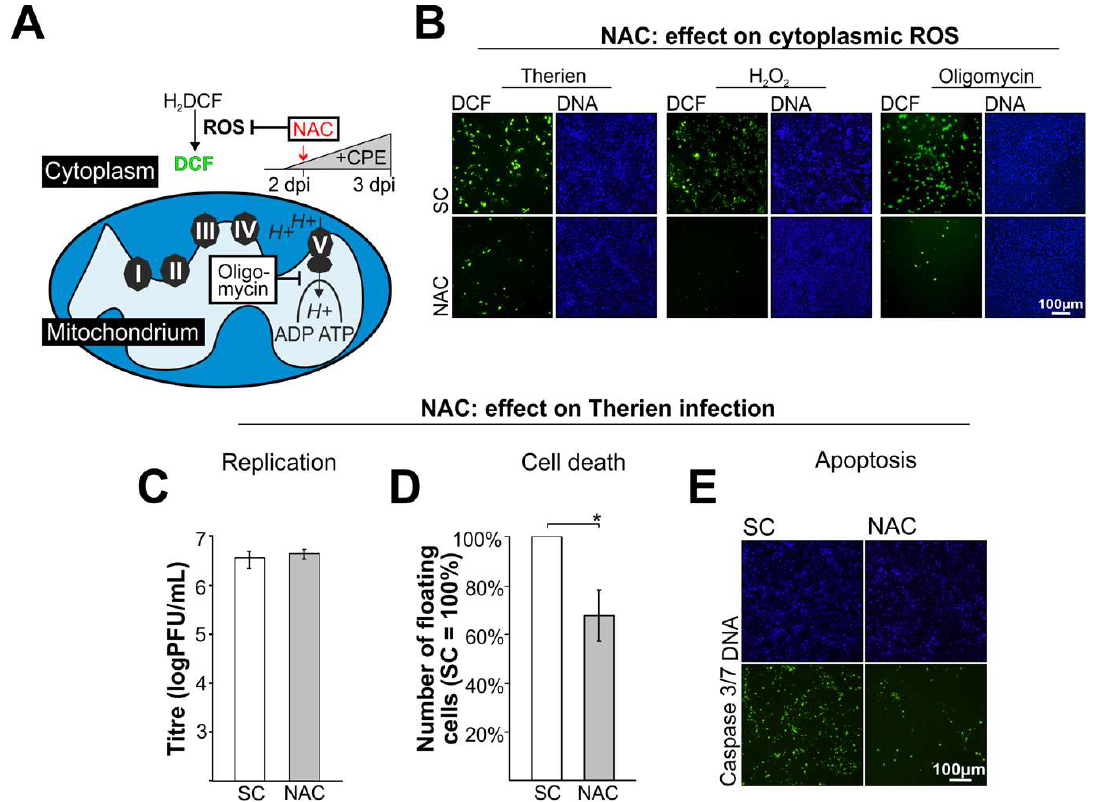
Figure 2. The ROS scavenger N -acetyl- L -cysteine (NAC) reduces RV-associated cytopathogenicity including induction of apoptosis. ( A ) Schematic overview of the application of NAC to RV-infected Vero cells at 2 dpi before the onset of cytopathogenic effect (CPE). The effect on ROS generation was detected by conversion of the non-fluorescent H 2 DCF to the fluorescent DCF; ( B ) The cytoplasmic ROS scavenger NAC was applied at 2 dpi to Vero cells infected with the cytopathogenic RV strain Therien. As positive controls, H 2 O 2 and the ATP synthase inhibitor oligomycin were used. The effect on ROS generation was monitored through microscopic analysis of DCF fluorescence; ( C – E ) The effect of